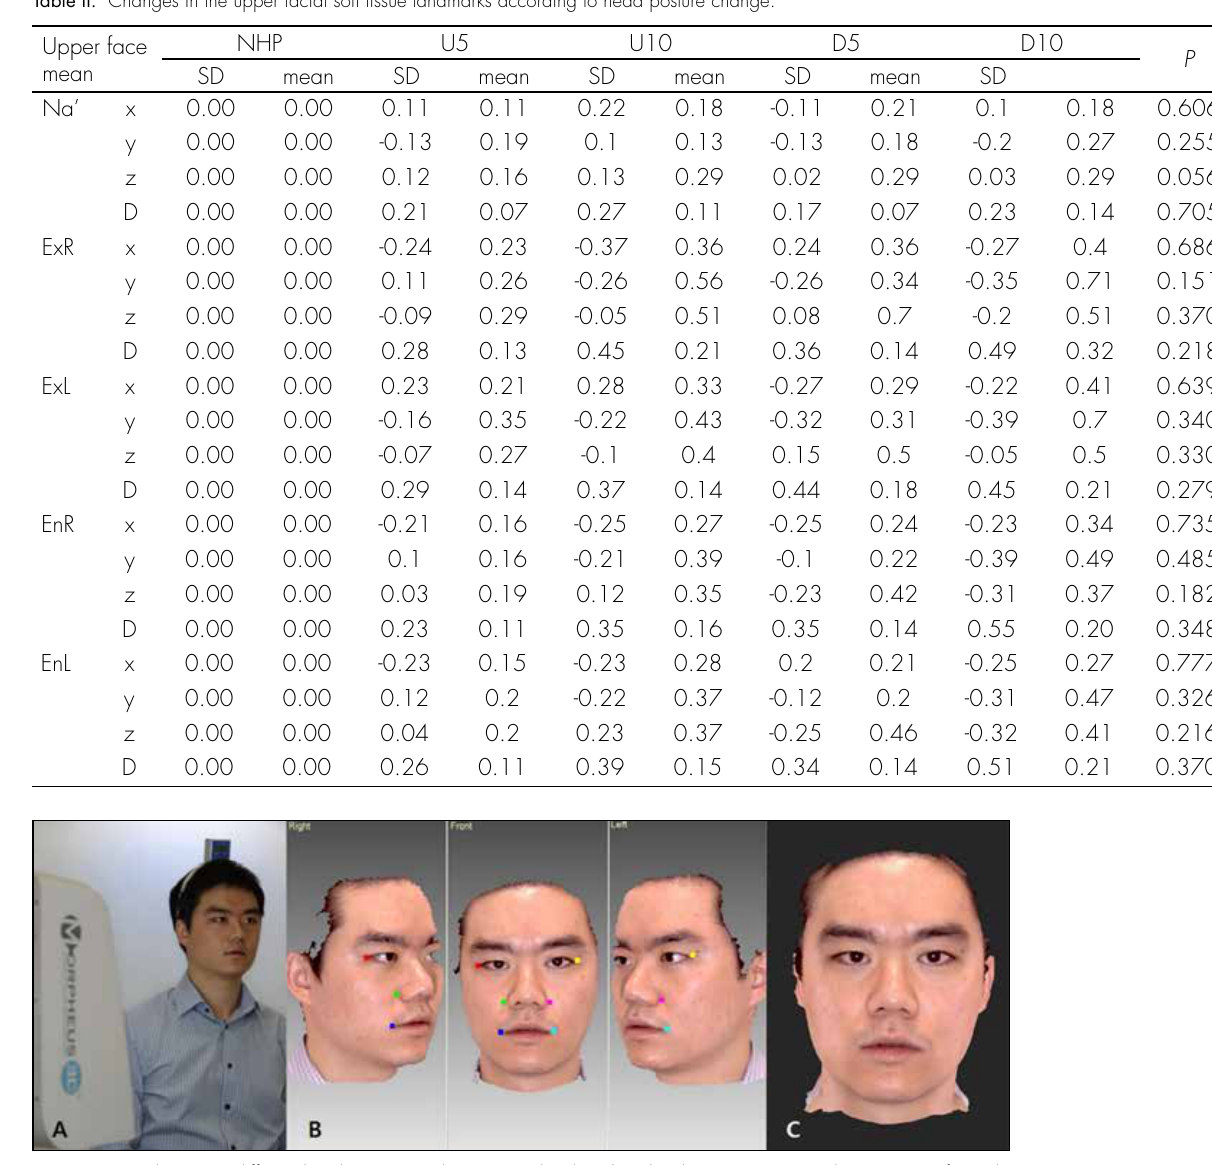
Figure 3. Facial scans at different head posture angles measured with a digital inclinometer (A). Facial scanning performed in three different horizontal angles (-45°, 0°, 45°) and six selected circumjacent points to merge three images (B), to create a reconstructed three-dimensional facial image (C).